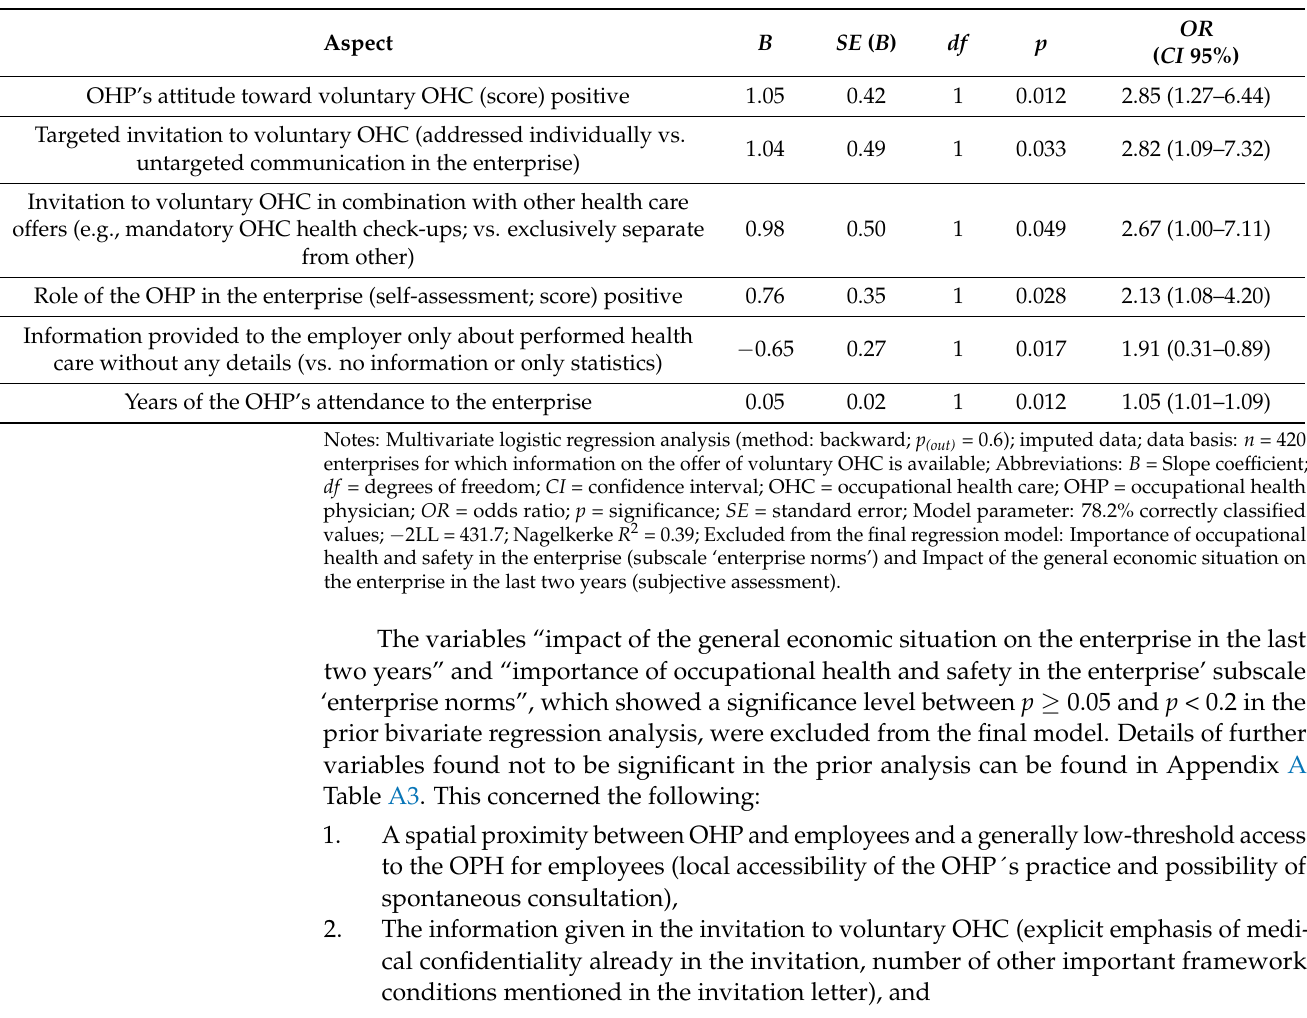
Table 6. Factors influencing the uptake of voluntary OHC from the perspective of occupational health